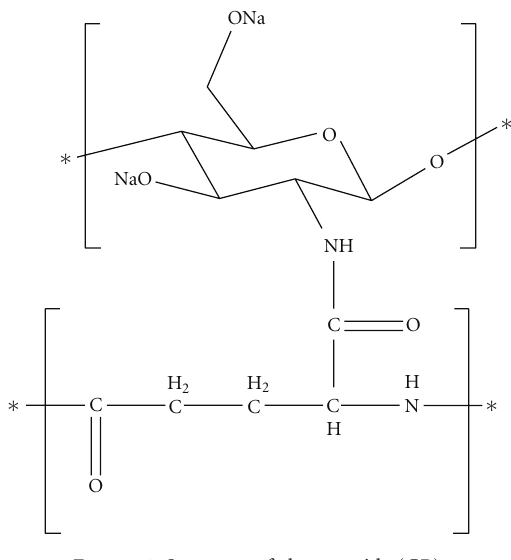
Figure 1: Structure of glycopeptide (GP).